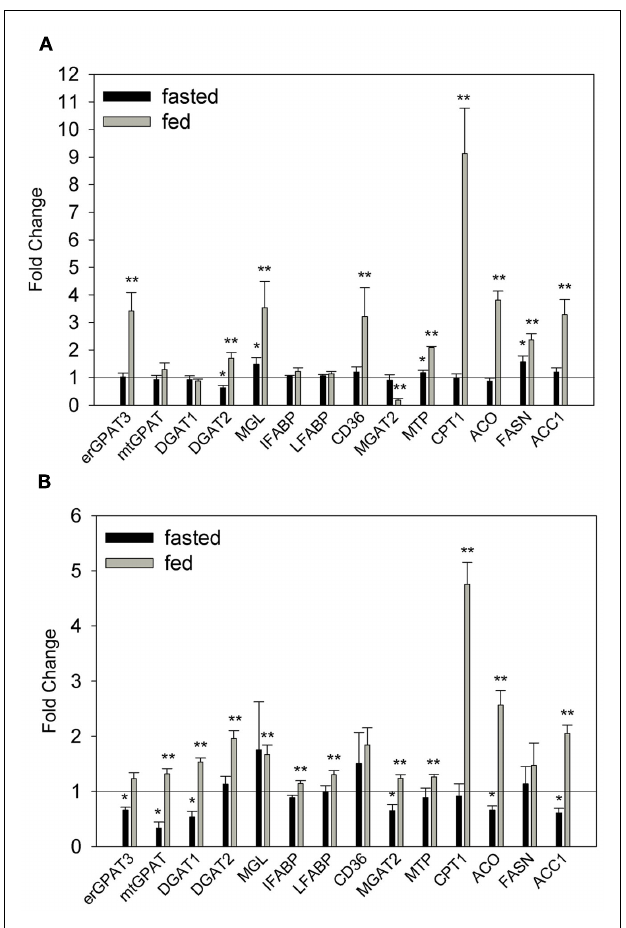
FIGURE 4 | Relative quantitation of mRNA expression of lipid metabolic and transport genes. (A) Fasted and fedWT–HF mice relative to fasted and fedWT–LF mice. (B) Fasted and fed ob/ob mice relative to fasted and fedWT–LF mice. Average ± SEM, * p < 0.05 or lower versus fastedWT–LF, ** p < 0.05 or lower versus fedWT–LF, n = 3–6 per group.